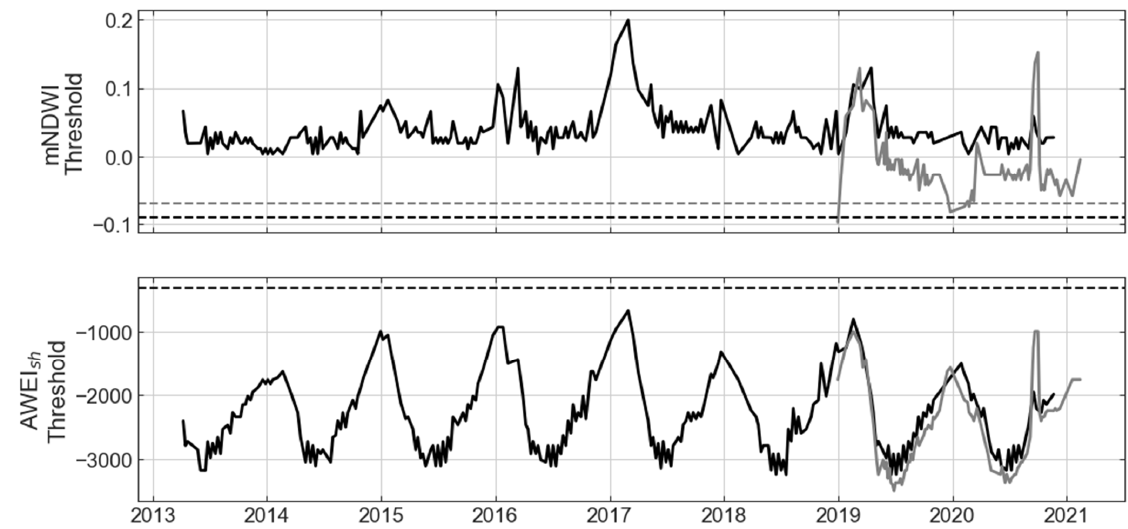
Figure 3. Computed mNDWI and AWEI sh threshold values using Otsu’s binarization algorithm. Black line represents LandSat-8 products while gray line represents Sentinel-2 products. Dashed lines indicate defined single thresholds.